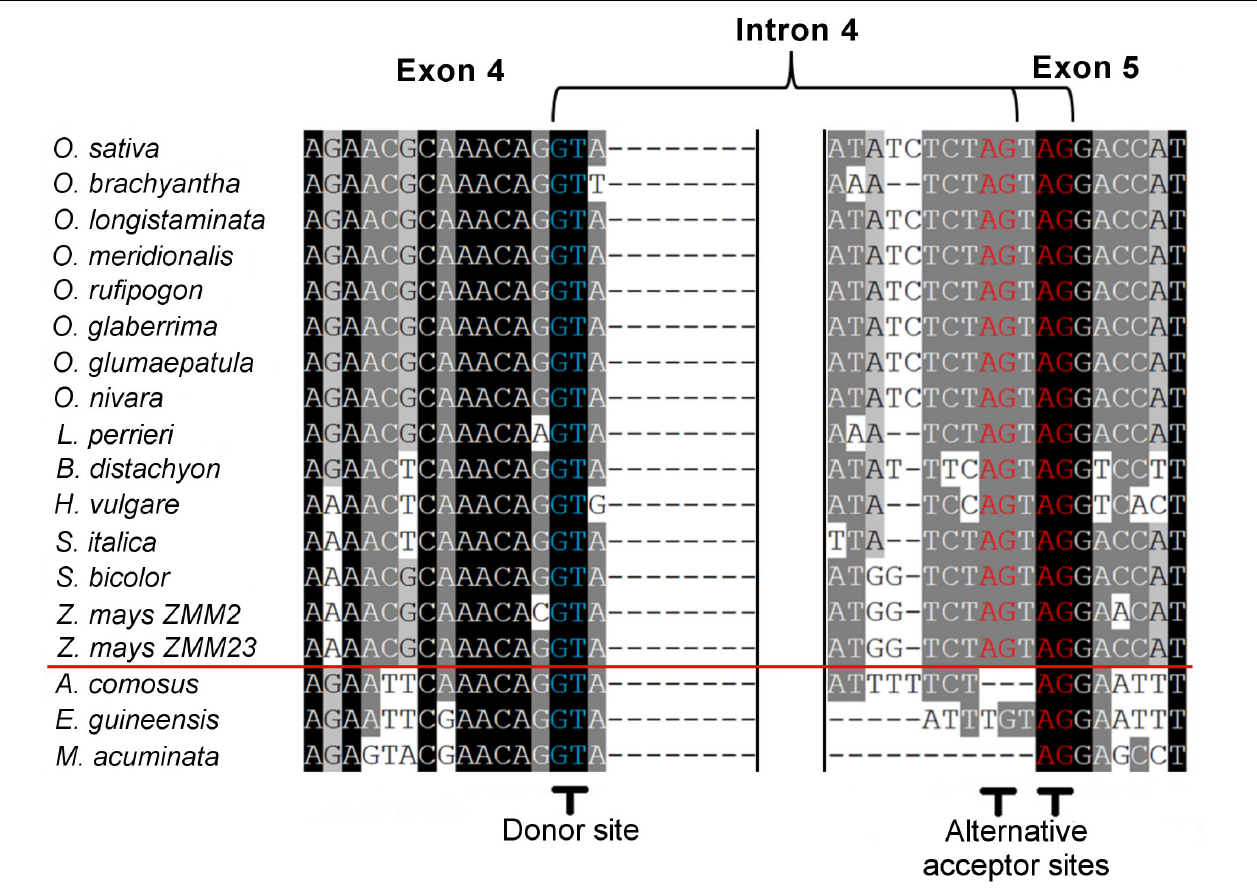
FIGURE 3 | Alignment of corresponding fourth intron splicing sites from the pre-mRNA of OsMADS3 and its direct orthologs from different monocotyledon species. The red line divides grasses (above) and non-grasses (below). The 5 (cid:48) donor sites and the 3 (cid:48) alternative acceptor sites are shown in blue and in red,